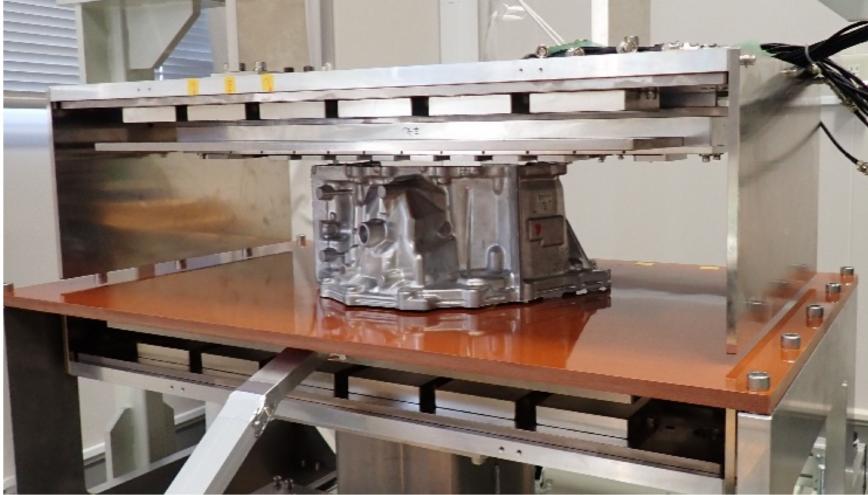
Figure 16. Photograph of the measurement using the fabricated